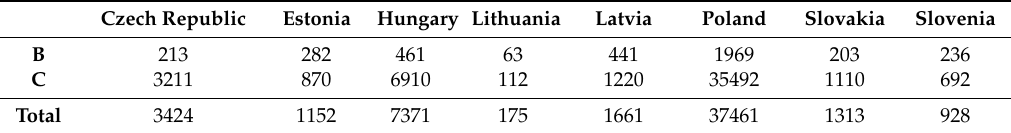
Table 1. Number of farms in the experimental and control